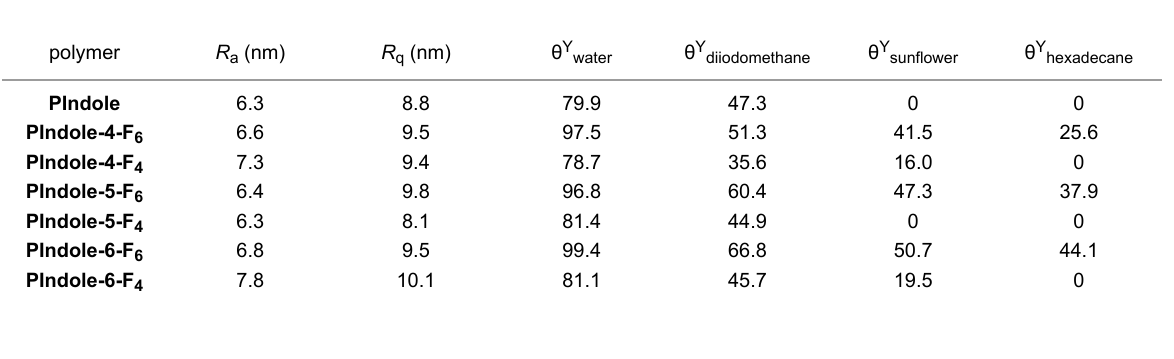
Table 4: Arithmetic roughness ( R a ), quadratic roughness ( R q ) and apparent contact angles ( θ ) for the four probe liquids (water, diiodomethane, sunflower oil and hexadecane) for the “smooth” polymers.